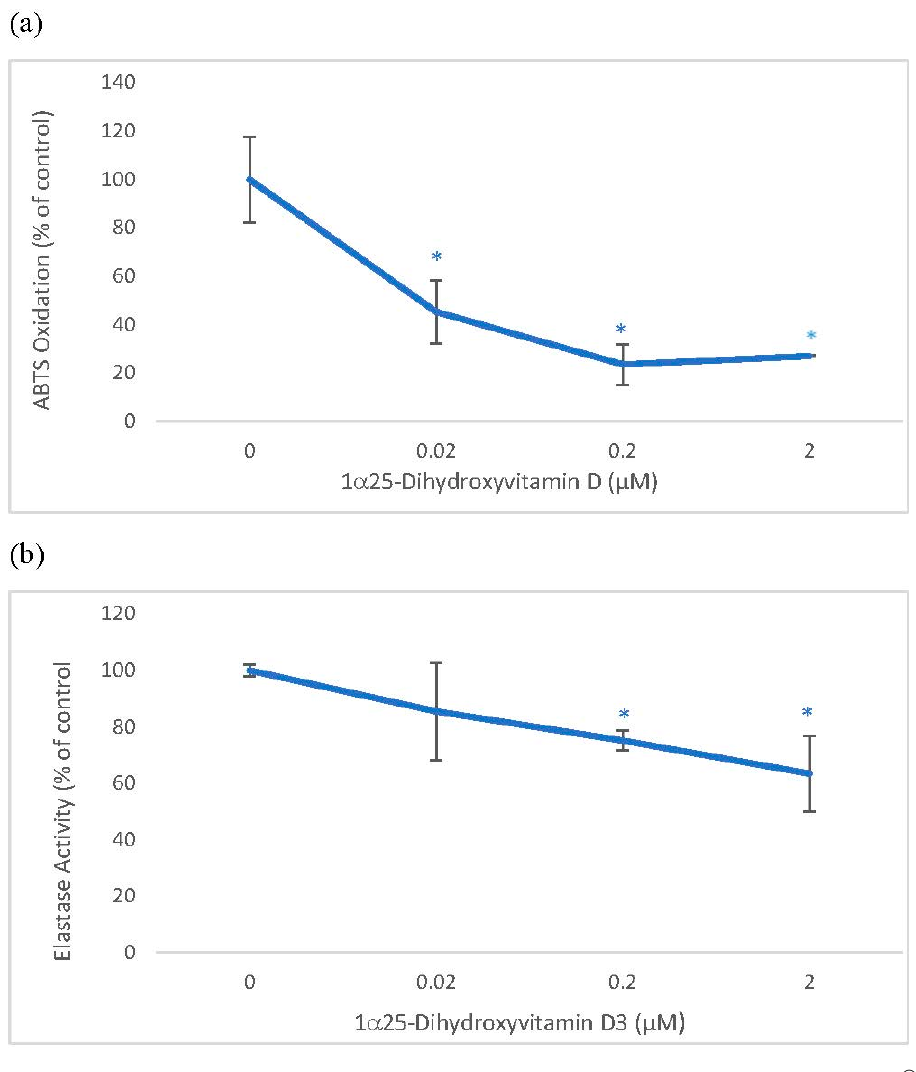
Figure 1. Direct Effects of 1 α , 25 dihydroxyvitaminD3 (Vitamin D) on ABTS ® (2, 2 ′ -azino-di-[3-ethylbenzthiazoline sulphonate]) Oxidation and Elastase activity. Vitamin D (0–2 µM) was incubated with respective assay reactants and products measured to determine its effect on ABTS oxidation ( a ), and elastase activity ( b ). The effect of vitamin D is represented as % of control (0 µM), represented at 100%; * = p < 0.05, relative to control. Error bars represent standard deviation, n = 4.